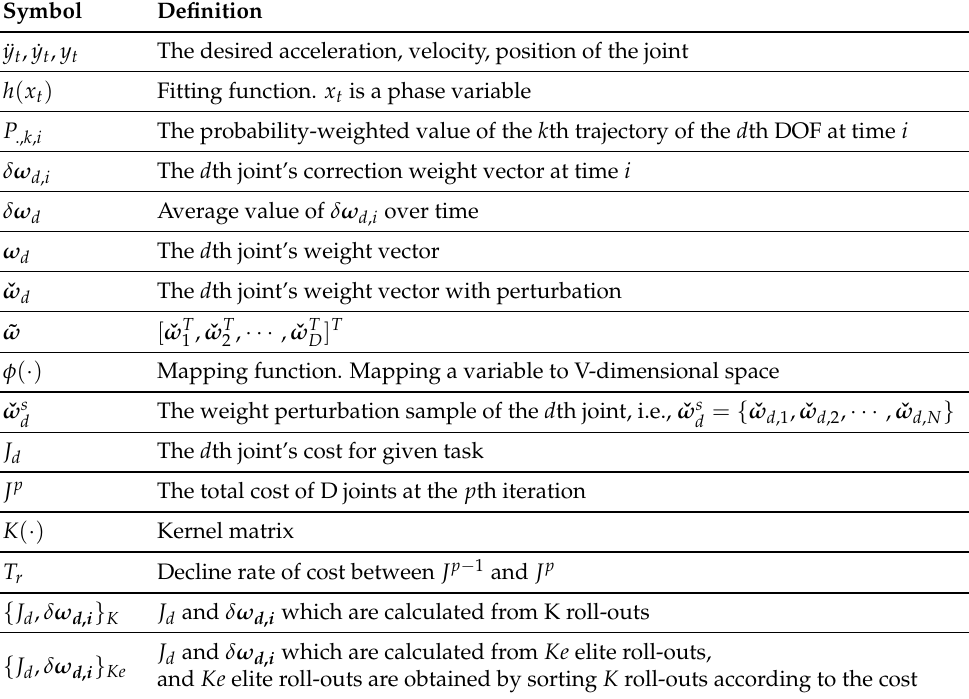
Table 1. Summary of the notation frequently used in the